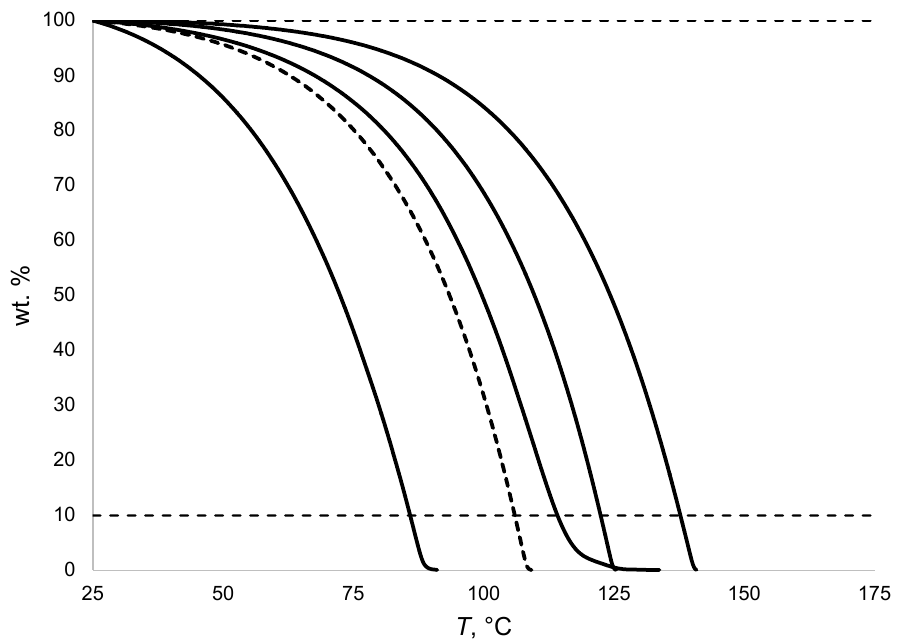
Figure 2. The TGA evaporation curves for IPB and SBB. From left to the right: TMD, BuOAc, ETMD, IPP, SBB. Table 8. The evaporation rates for the renewable diols derivatives calculated from the TGA measurements.